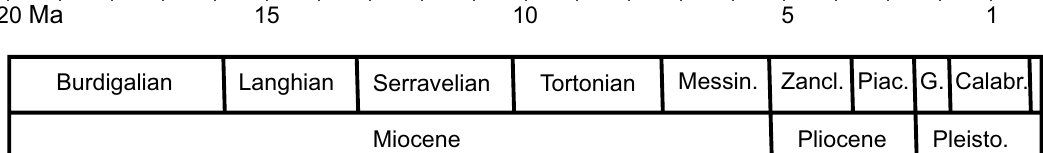
Figure 3. Bayesian estimates of median molecular divergence times (median dates next to node) based on concatenated ATPase-6 andATPase-8, as derived from analysis using BEAST and calibrated using minimum age of genus and substitution rates from Diadema , a confamilial genus. Bars indicate 95% Highest Posterior Density (HPD) limits. Ages of stages and epoch series based on International Commission on Stratigraphy stratigraphic chart v.2020/01 30 (Messin. = Messinian, Zancl. = Zanclean, Piac. = Piacenzian, G. = Gelasian, Calabr. = Calabrian, Pleisto. =